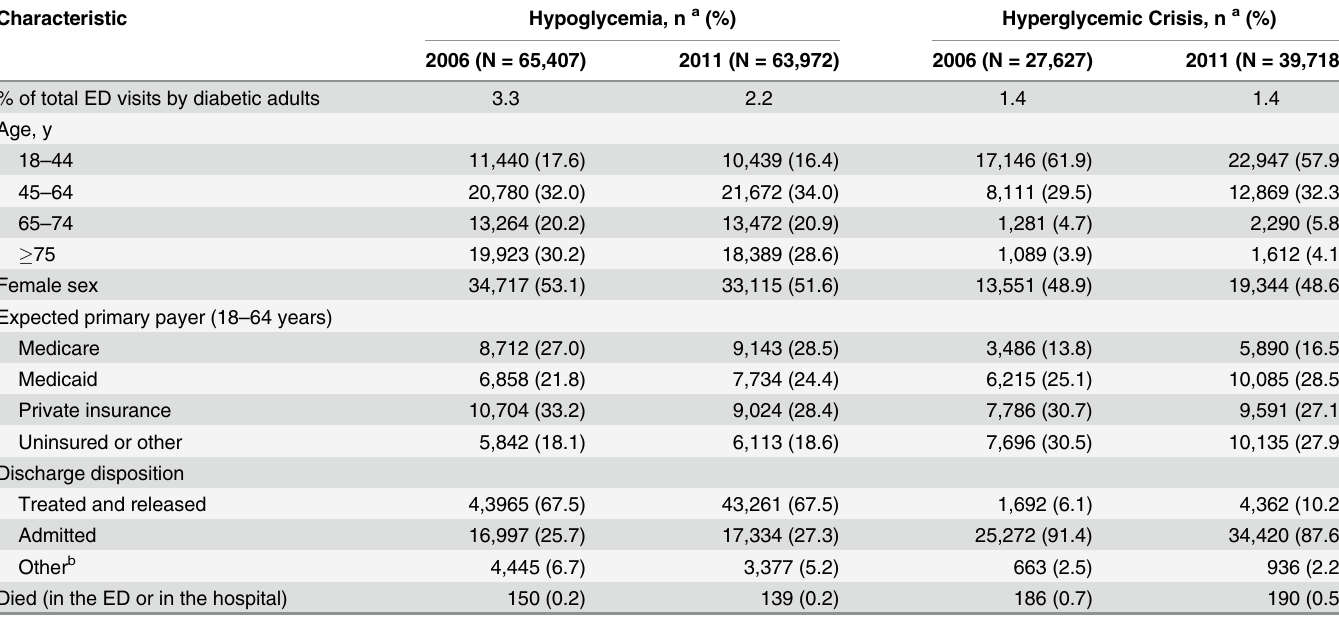
Table 1. Characteristics of Emergency Department Visits for Hypoglycemia or Hyperglycemic Crisis Among Adults With Diagnosed